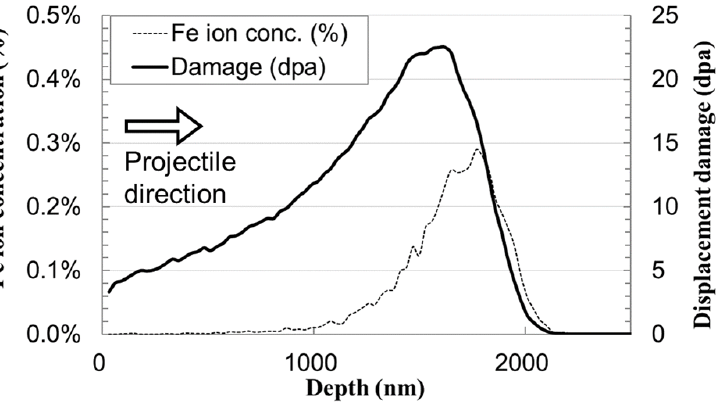
Figure 1. Distributions of Fe ion-irradiation damages and Fe ion implantations in a Fe-18Cr-14Ni alloy.